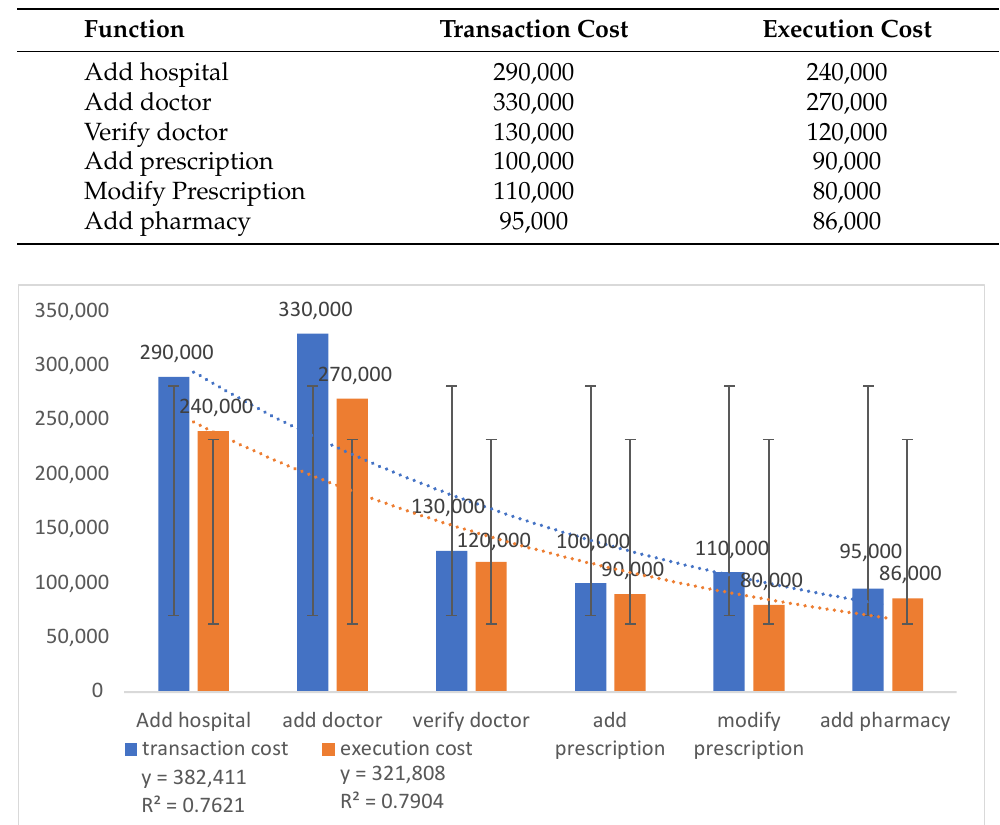
Figure 14. Function cost comparison for transactions and